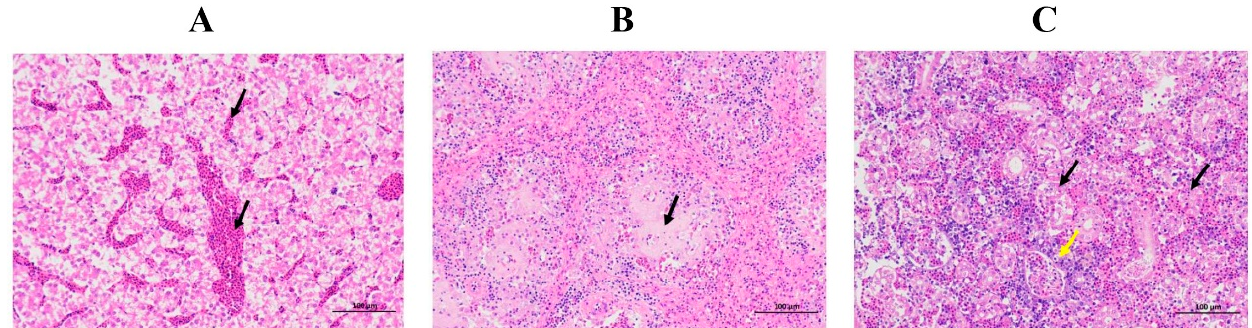
abdominal enlargement ( A ), and the purple arrows represent intussusception ( B ) in channel catfish.